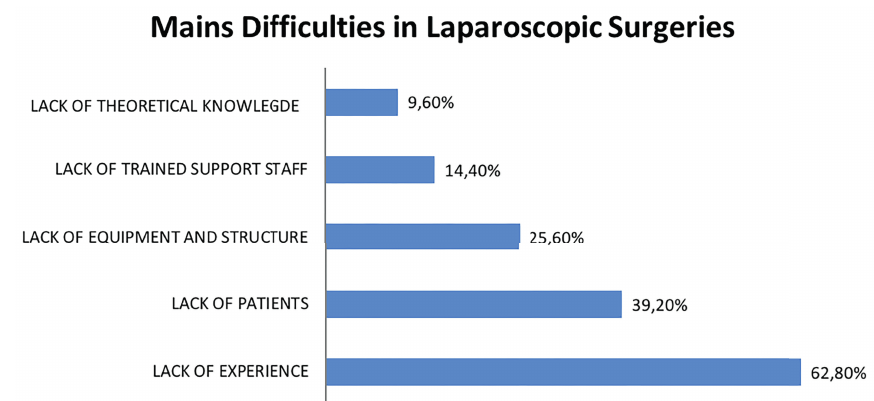
Figure 3 - Mains diffi culties in laparoscopic surgeries.